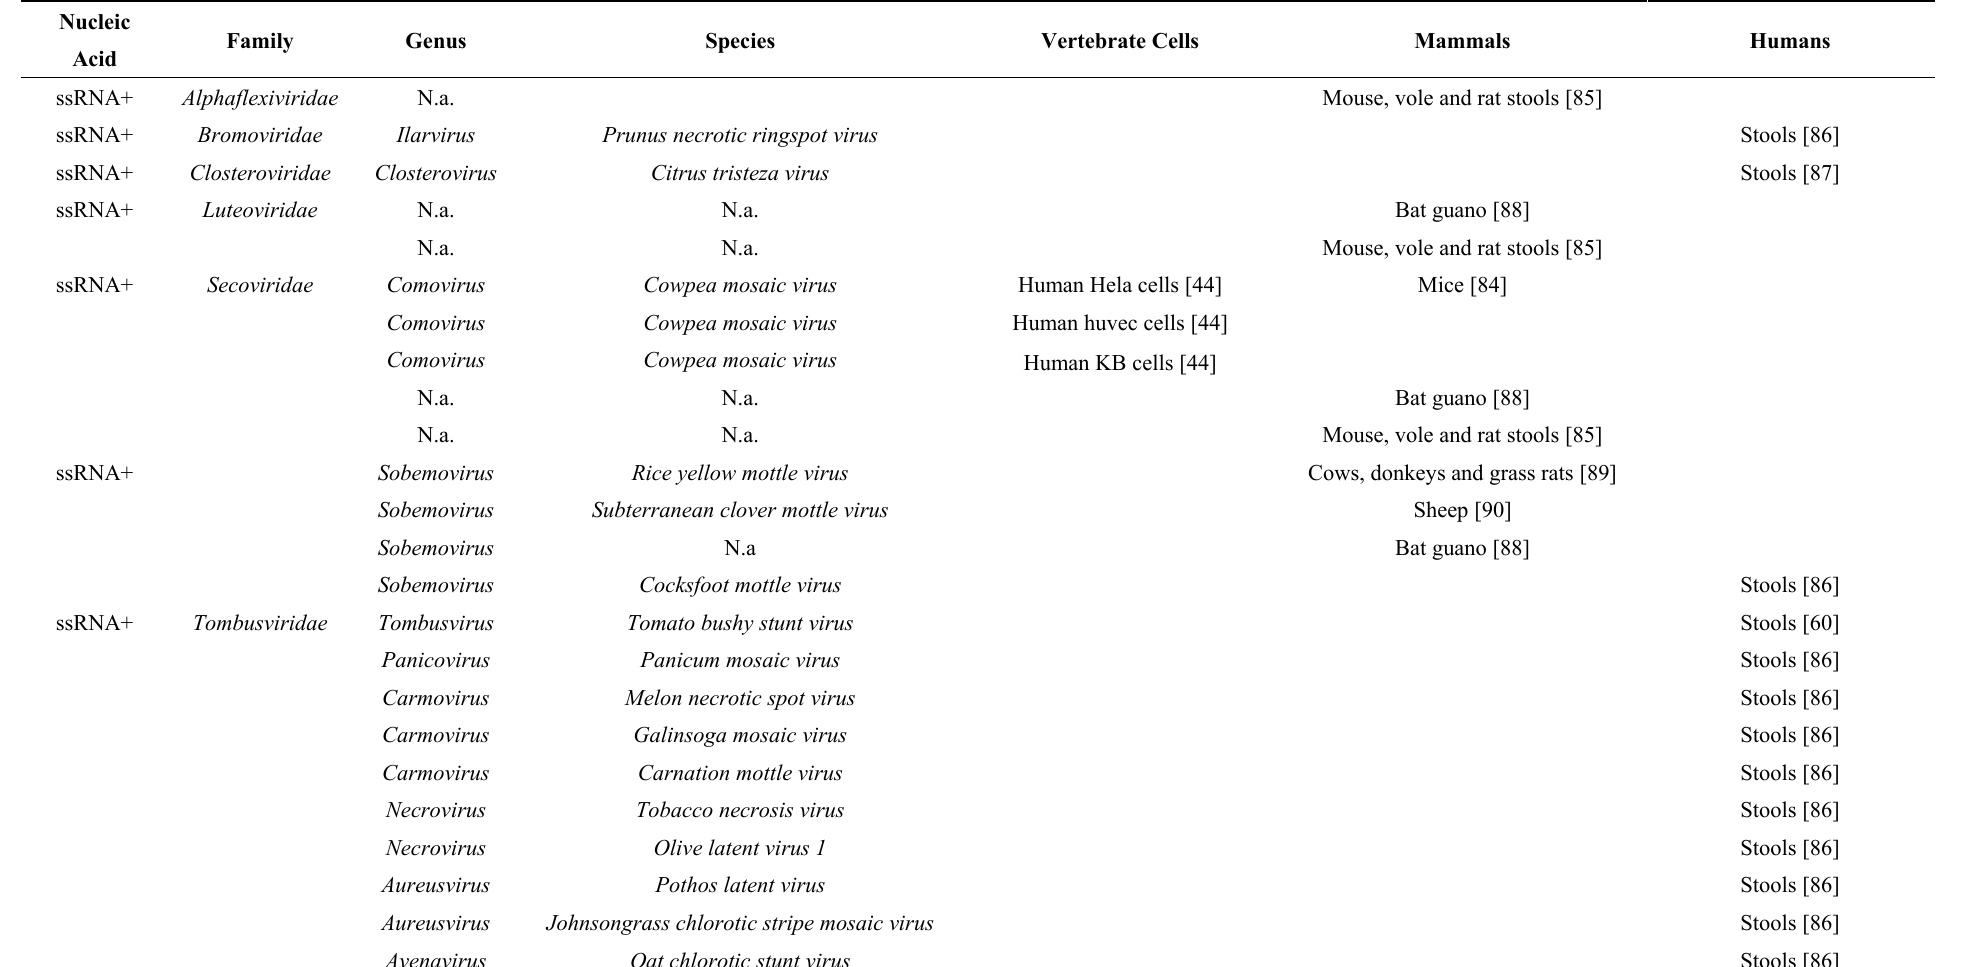
Table 2. Plant viruses detected in humans or non-human mammals or shown to interact in experimental in vitro studies with humans or non-human